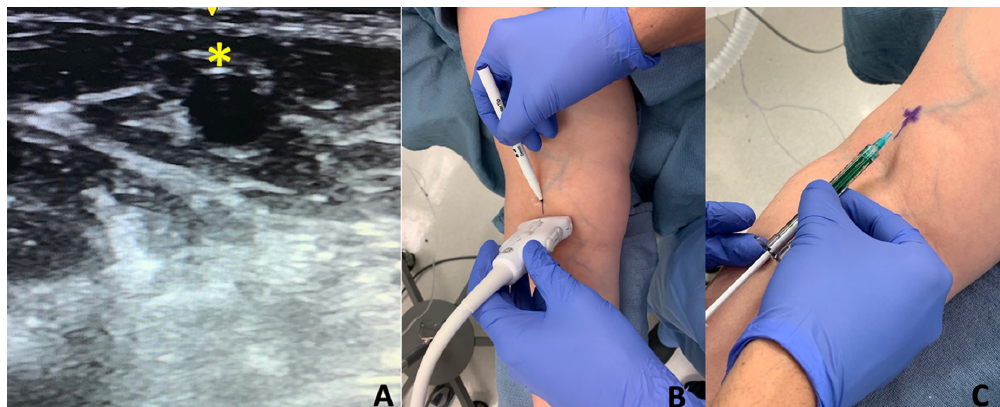
Figure 3. Preoperative ultrasound (US) localization over the cephalic vein. ( A ) The asterisk (*) demarcates the location of the cephalic vein using ultrasound technology. ( B ) Depiction of the operating surgeon mapping out the injection point 4 cm distal to the antecubital crease over the cephalic vein. ( C ) Targeted injection of ICG and albumin mixture to map the lymphatic anatomy of the upper extremity.